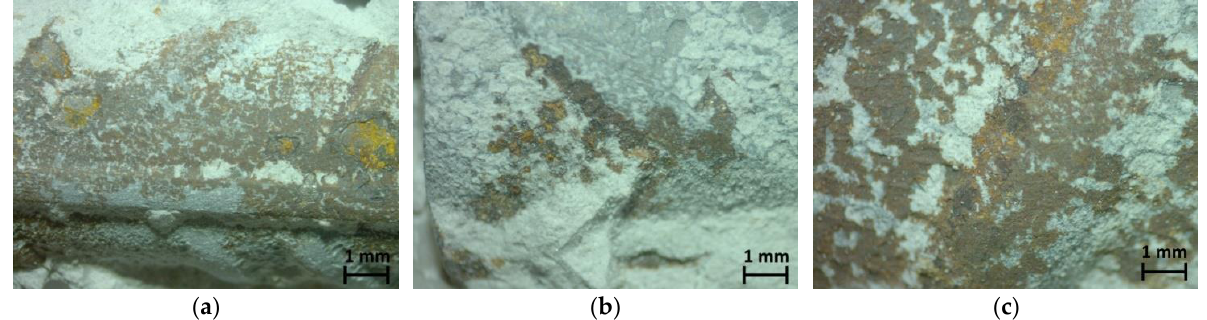
Figure 8. Stereoscopy images: ( a ) RM, ( b ) HDPE, ( c ) PP. 3.4. EIS Measurements The electrochemical process of the corrosion of reinforced concrete is represented in terms of its electrical analogue of resistance, capacitance, or inductance in various arrange- ments corresponding to the possibilities of the physical model. Figure 9 illustrates the equivalent circuit found after fitting. In the equivalent circuit, Rs is the electrolyte re- sistance (concrete pore solution). A circuit with two parallel elements was connected in series with the resistance Rs to simulate the high-frequency loop that may be attributed to the dielectric properties of the concrete cover. It consists of two parallel elements, a re- sistance Rc and a constant phase element CPE1. They are related to the concrete pore so- lution and the porosity of hydrated concrete. The impedance of a constant phase element is defined as [30 ]: Z(ω ) = Y 0 −1 (jω) n , where Y 0 is a parameter used in nonlinear least squares fitting, ω is the angular frequency , and n is a measure of arc depression defined as constant phase element power. For n = 0, the impedance simplifies an ideal resistor. For n = 1, a CPE simplifies as a pure capacitor, and as a result, the resistance obtained from fitting is very high (>10 8 Ohm.cm 2 ). When n approaches 1, it is common practice to use the Y 0 value as an approximation for capacitive behavior [35]. Another circuit with parallel elements,